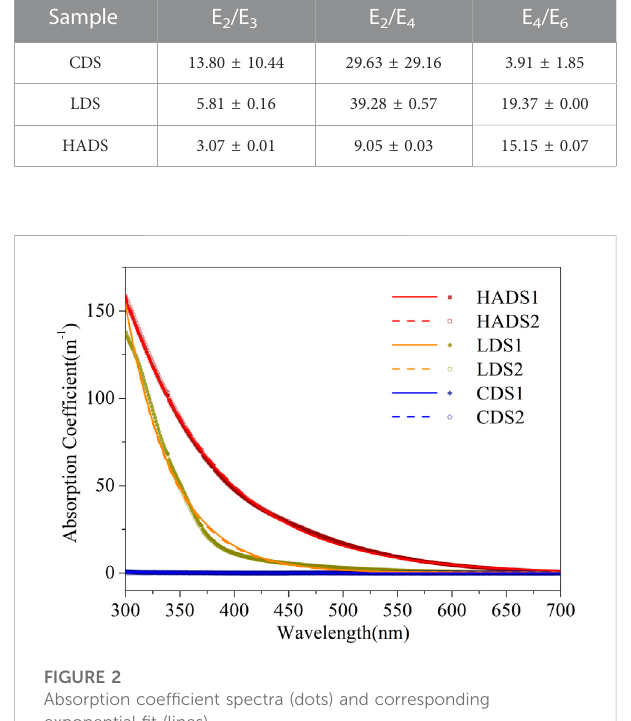
FIGURE 2 Absorption coef fi cient spectra (dots) and corresponding exponential fi t